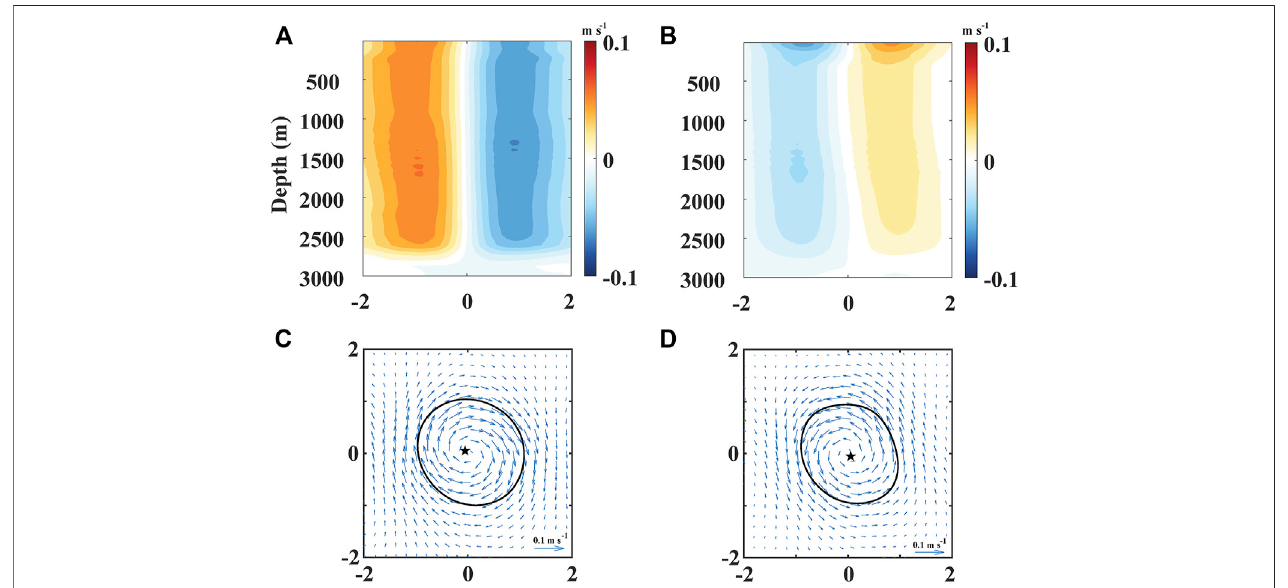
FIGURE5|(A) Thezonalcross-sectionofcompositemeridionalvelocityanomaliesoftheCE acrosstheeddycenterintheCTRLRUN. (B) Sameas (A) ,butforthe composite eddy of AE. (C) Horizontal distribution of composite velocity vector anomalies of the CE at the surface layer in the CTRLRUN. (D) Same as (C) , but for the composite eddy of